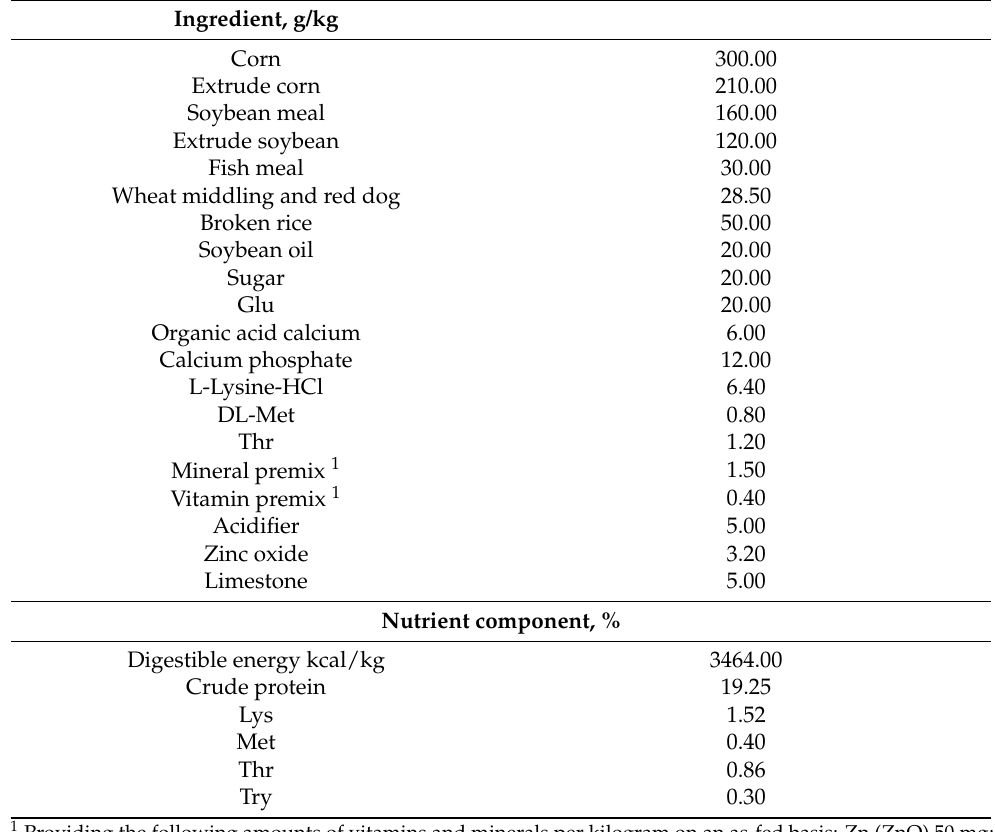
Table 1. Basic diet composition and nutritional level of